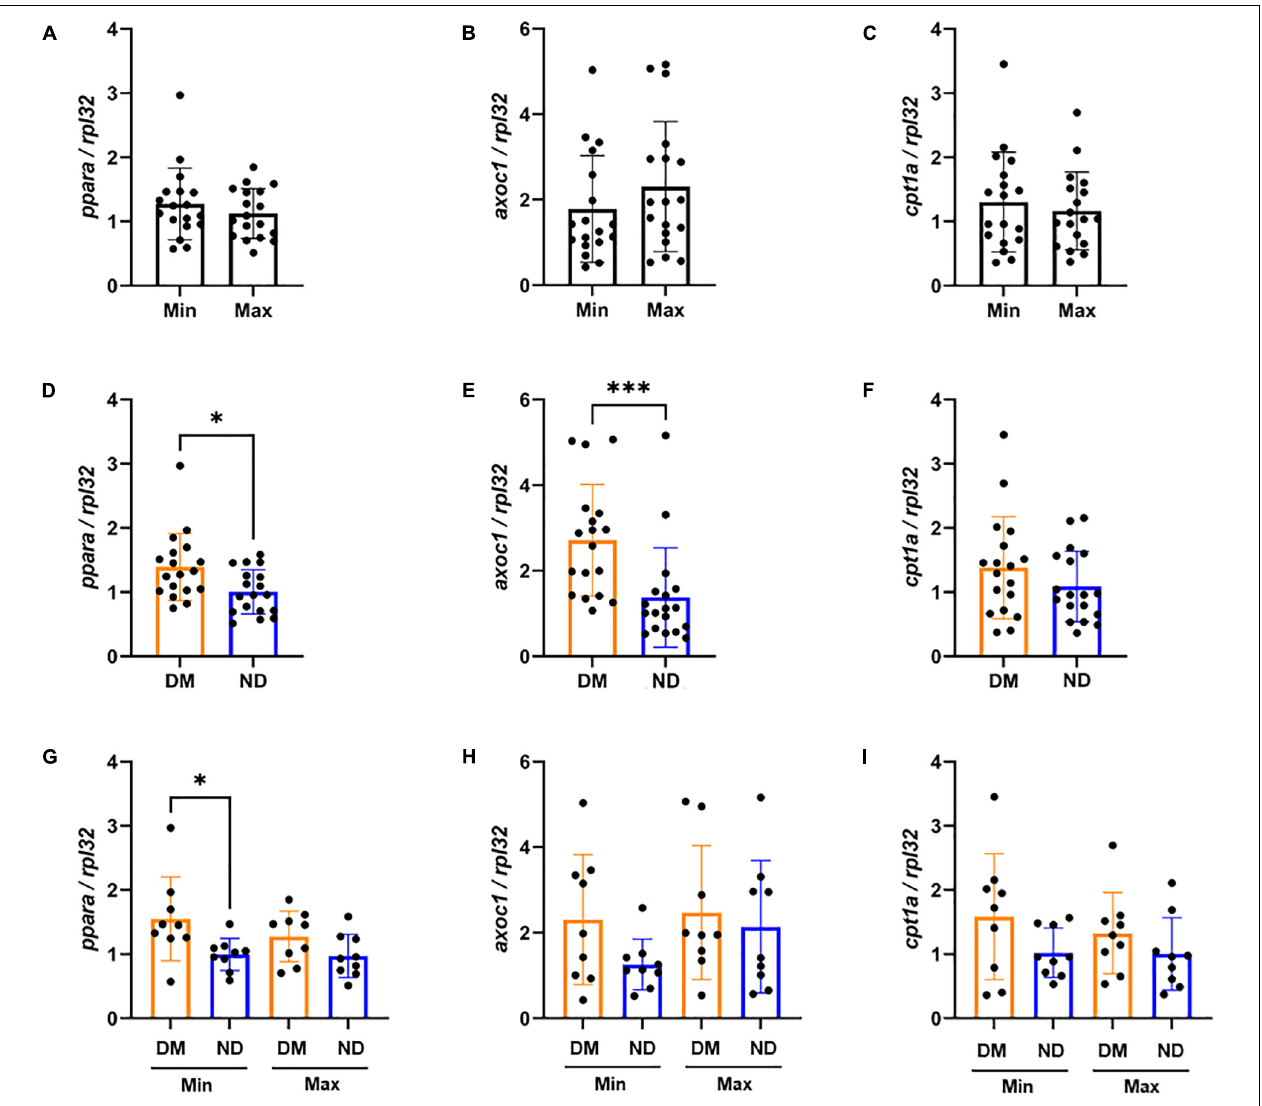
FIGURE 2 | mRNA expression variability of carotid endarterectomy plaques by lesion severity and diabetic status (A–C) No significant difference in carotid artery plaque expression between the Min ( n = 18) and Max ( n = 18) segments of ppara , acox1 , and cpt1a mRNA expression. (D–F) Combined Min and Max analysis of patients with diabetes ( n = 18) demonstrate significantly higher mRNA expression of ppara ( p < 0.05), and acox1 ( p < 0.001) compared to patients without diabetes. We did not observe a difference between cpt1a mRNA expression between patients with or without diabetes. (G–I) When distinguishing both disease severity and diabetic status, we found significant increase in ppara mRNA expression in patients with diabetes ( n = 9) compared to patients without diabetes ( n = 9). We found no significant differences in acox1 or cpt1a expression. DM, Diabetic. ND, Non-diabetic. Min, Minimally diseased. Max, Maximally diseased. Data are presented as mean ± SD, and each point represents one patient sample. ∗ p < 0.05 and ∗∗∗ p <